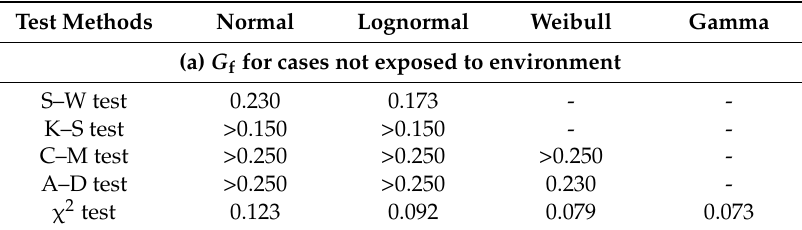
Table 2. Test results of probability distribution of G f